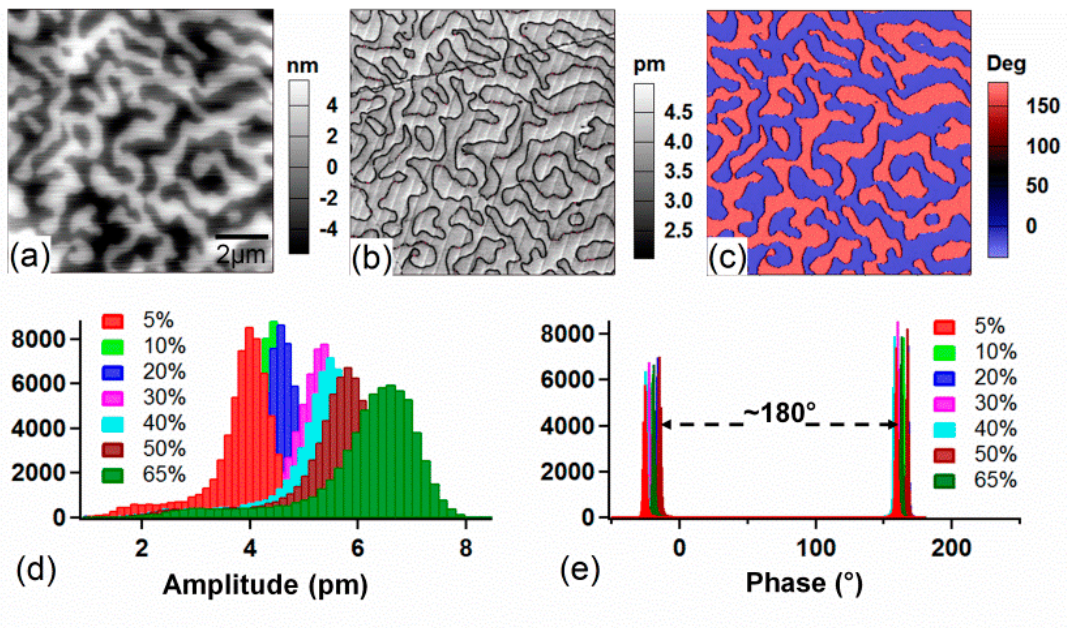
Figure 1. ( a ) Topography, ( b ) PFM amplitude, and ( c ) PFM phase images of the PZN − 9%PT single crystal. ( d , e ) Histogram distribution of PFM amplitude and phase under various relative humidity levels from 5% to 65%.